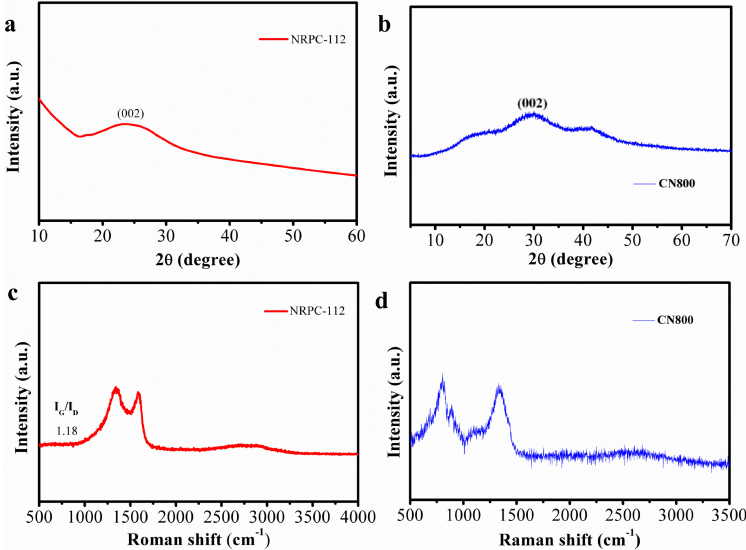
Figure 6. ( a ) XRD patterns of NRPC-112, ( b ) Raman spectra of NRPC-112, ( c ) XRD patterns of CN800, ( d ) Raman spectra of CN800.